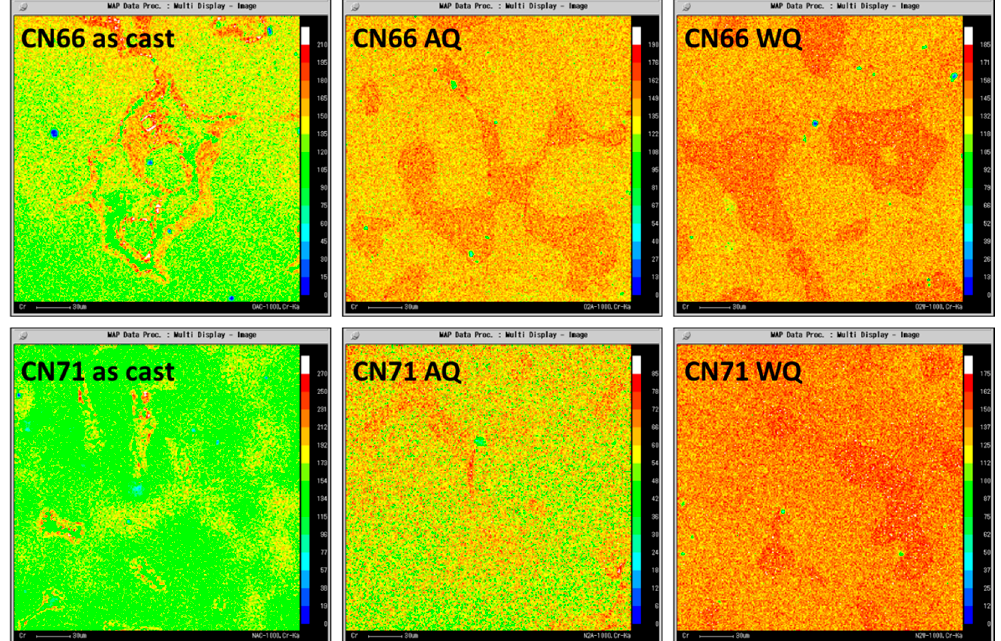
Figure 2. Compositional analyses of CN66 and CN71 with different heat treatment conditions (as-cast, solution treated and air-cooled (AQ), and solution treated and water quenched (WQ)), to determine their chromium content by electron probe micro-analysis (EPMA).